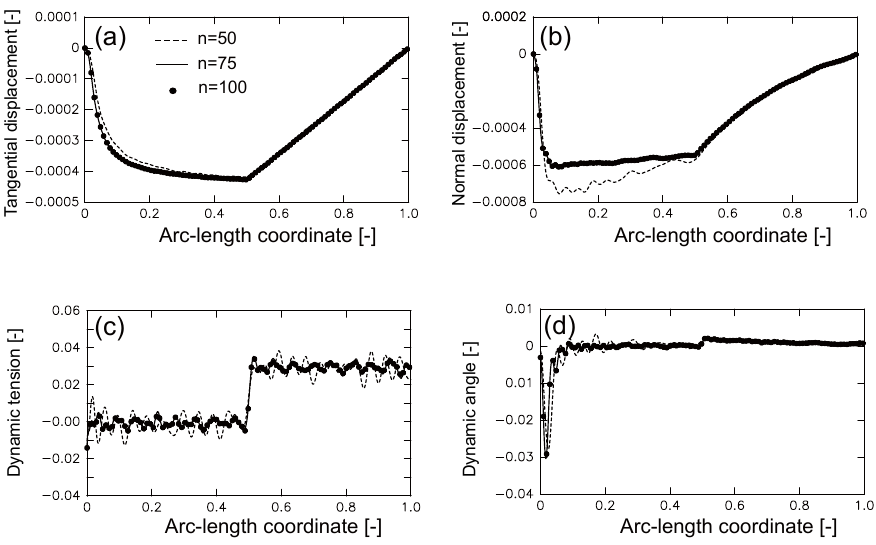
Figure 4. Convergence of the computed results using three maximum numbers of mode expansion, n = 50, 75, and 100: ( a ) tangential displacement; ( b ) normal displacement; ( c ) dynamic tension; and ( d ) dynamic